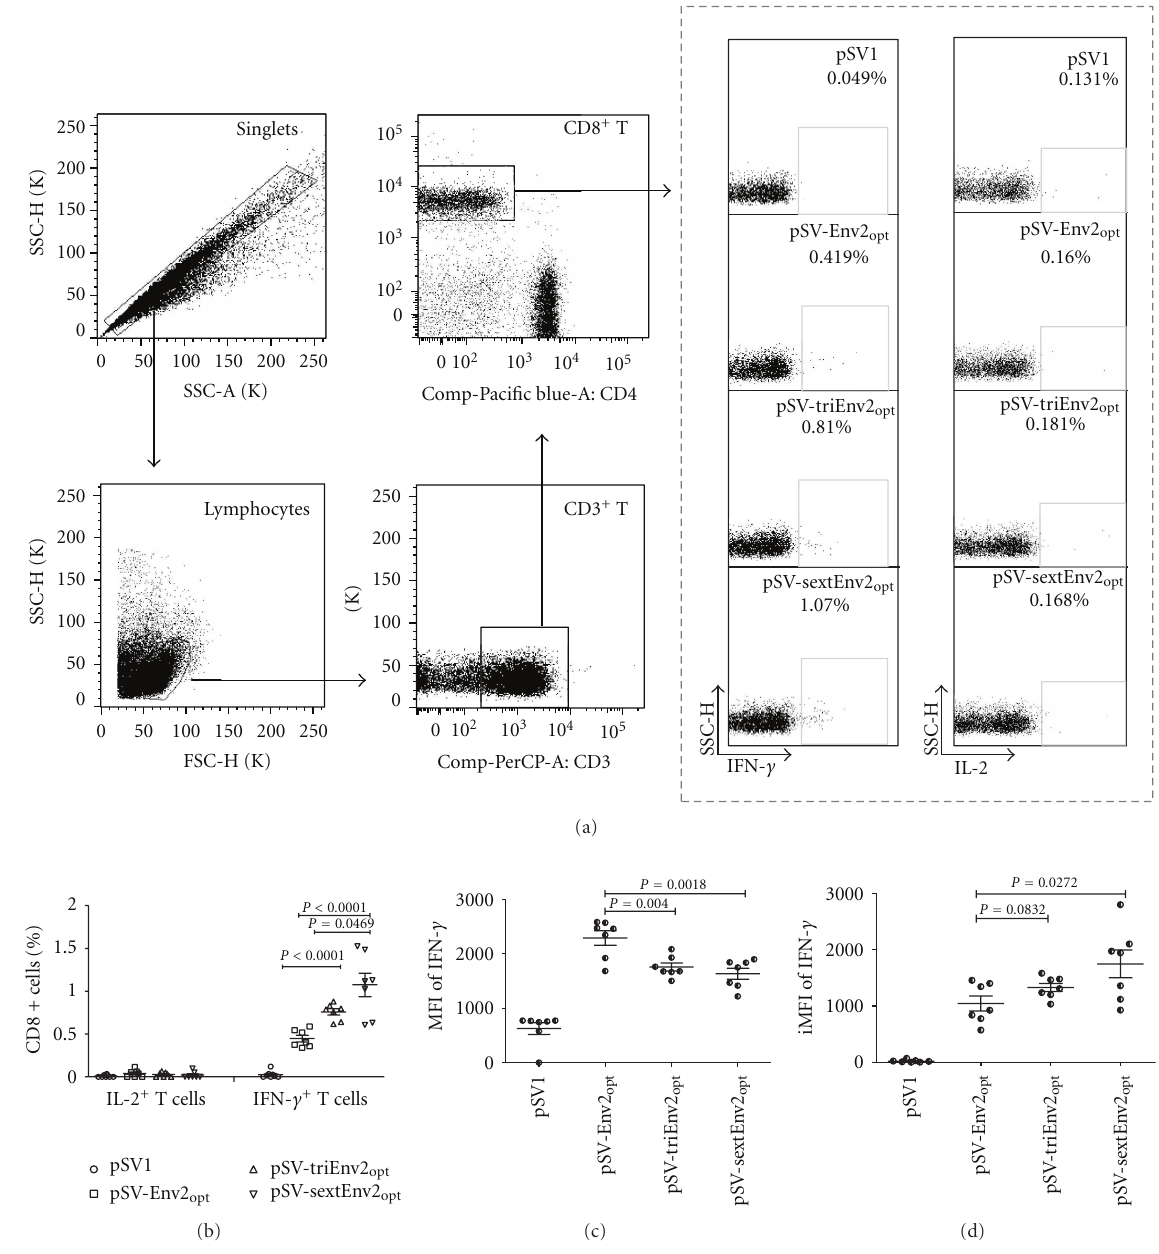
Figure 3: Immunogenicity comparison among groups of mice immunized with di ff erent epitope-based DNA vaccines. 100 μ g of purified plasmid DNA solved in 100 μ L sterile PBS was inoculated intramuscularly into tibialis anterior for three times at weeks 0, 2, and 4. 2 weeks after the final vaccination, the mice were sacrificed and splenocytes were freshly collected for intracellular cytokine staining (ICS) assay. (a) Representative flow cytometric analysis of IFN- γ and IL-2 secretion after stimulating mice splenocytes with Env2 peptide. The cytokines secretion profiles shown were gated on CD3 + CD8 + T cells. (b) pSV-Env2 opt , pSV-triEnv2 opt , and pSV-sextEnv2 opt could elicit appreciable IFN- γ secretion in CD8 + T cells and the frequencies of IFN- γ + CD8 + T cells ranked as pSV-Env2 opt < pSV-triEnv2 opt < pSV-sextEnv2 opt ( P < 0 . 0001). No significant IL-2 response was observed in any of the groups. (c) Compared with pSV-Env2 opt (2289 ± 348 . 7), the mean fluorescence intensity of IFN- γ in IFN- γ + CD8 + T cells elicited by pSV-triEnv2 opt (1755 ± 192 . 1) and pSV-sextEnv2 opt (1631 ± 263 . 7) was significantly lower. (d), the integrated mean fluorescence intensity (iMFI) of mice immunized with pSV-sextEnv2 opt was significantly higher than mice immunized with either pSV-triEnv2 opt or pSV-Env2 opt . The iMFI was calculated as multiplying the frequency of IFN- γ + CD8 + T cells by the corresponding mean fluorescence intensity of IFN- γ